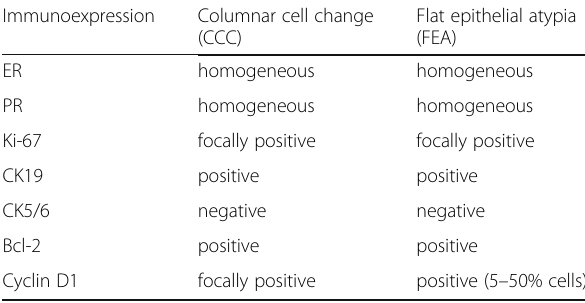
ER estrogen receptor, PR progesterone